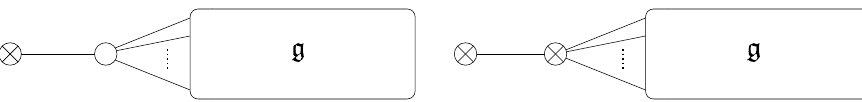
Figure 2 . Two equivalent Dynkin diagrams for B ( g + ) , W ( g + ) and S ( g + ) . Removing the “grey” node in the first diagram yields the Dynkin diagram of g + .